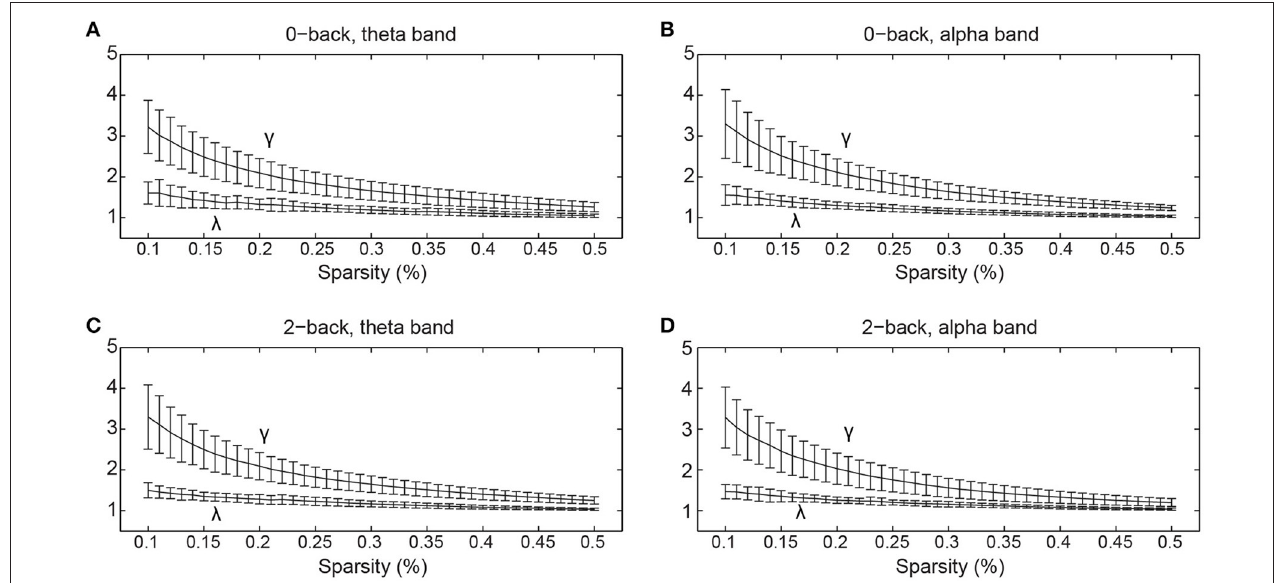
FIGURE 3 | The normalized clustering coefficient ( γ ) and normalized characteristic path length ( λ ) of the cortical functional connectivity networks over different sparsity values (mean ± standard deviation) in (A) 0-back task, theta band, (B) 0-back task, alpha band, (C) 2-back task, theta band, and (D) 2-back task, alpha